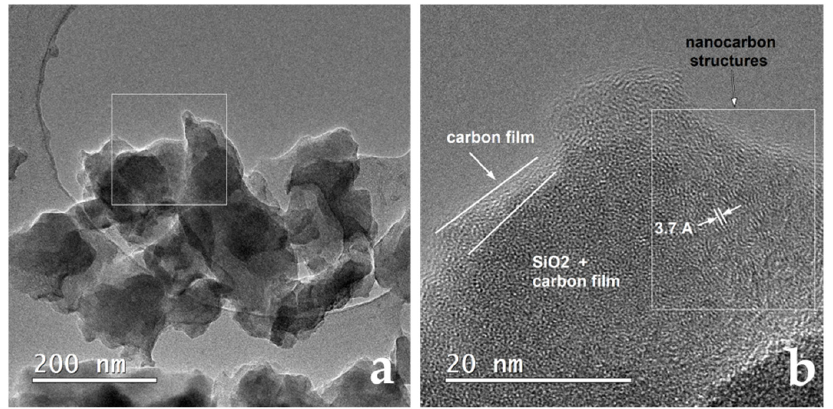
Figure 5. TEM image for the ( a ) C/SiO 2 -0.055 M at low magnification; HRTEM image for the ( b ) C/SiO 2 -0.055 M.